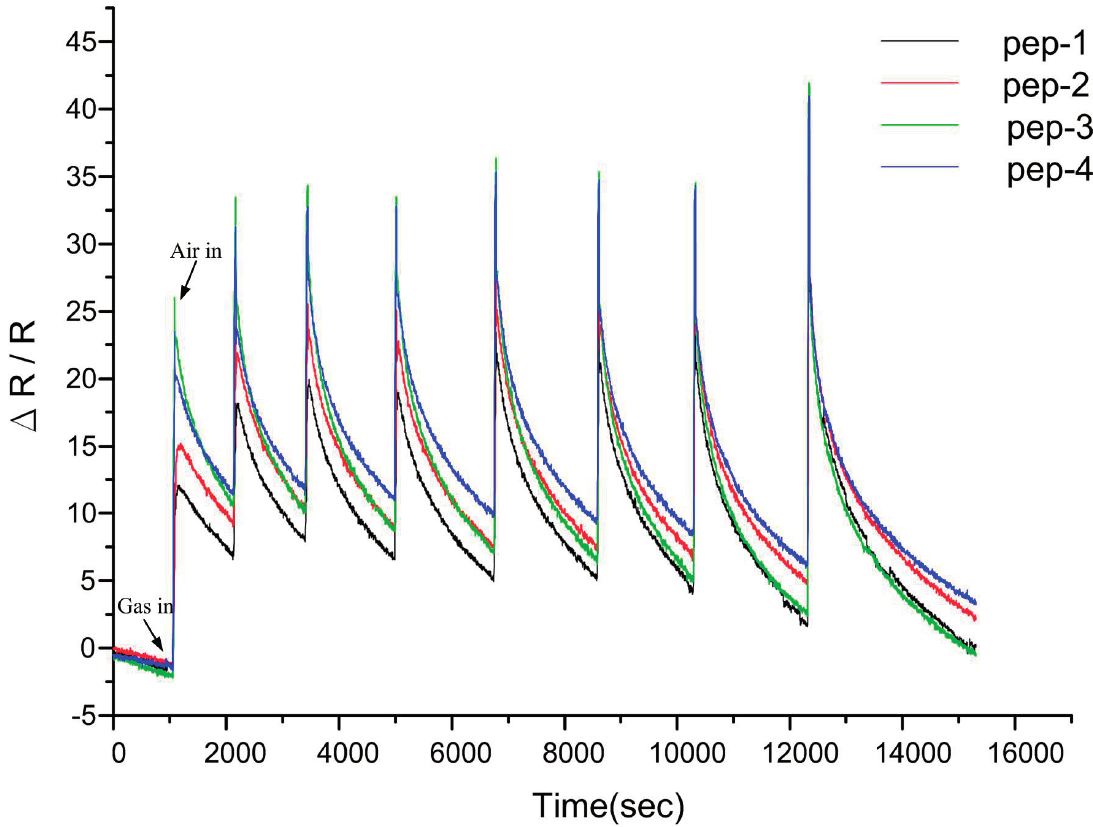
Figure 7. Long-term gas sensing responses to NH 3 gas of four sensor devices fabricated with the same sensing materials (41 wt% MWCNT-polypeptide composite